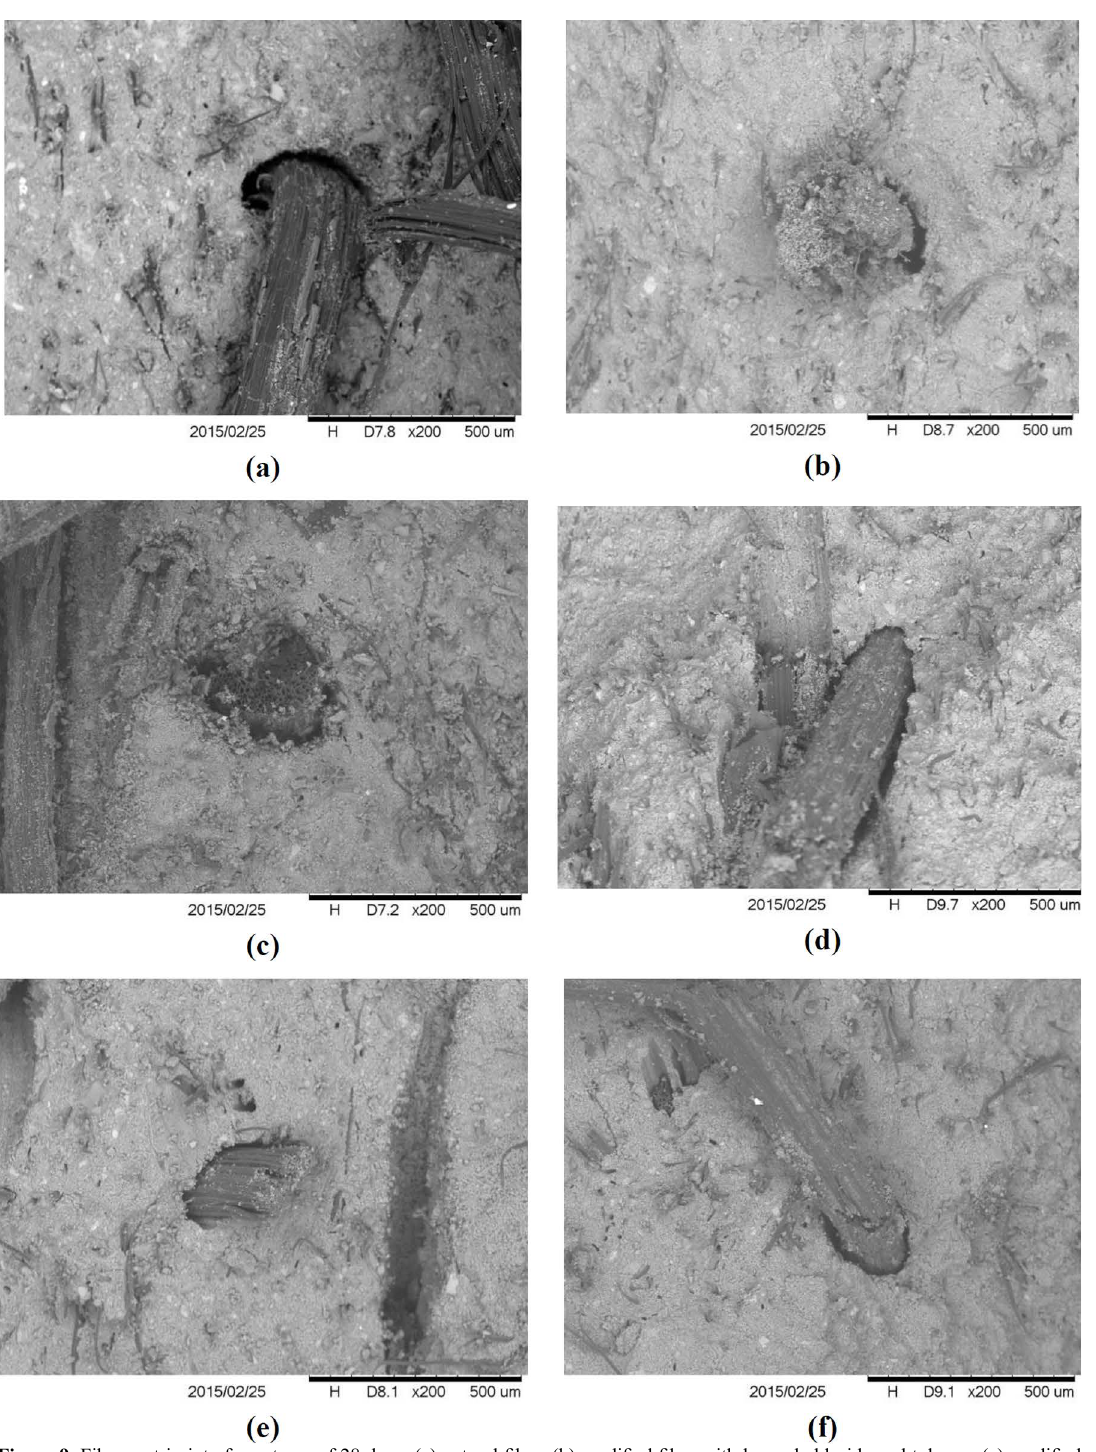
Figure 9. Fibre-matrix interface at age of 28 days: (a) natural fibre, (b) modified fibre with lauroyl chloride and toluene, (c) modified fibre with stearoyl chloride and toluene, (d) modified fibre with stearoyl chloride and DMF, (e) modified fibre with octanoyl chloride and toluene, and (f) modified fibre with octanoyl chloride and